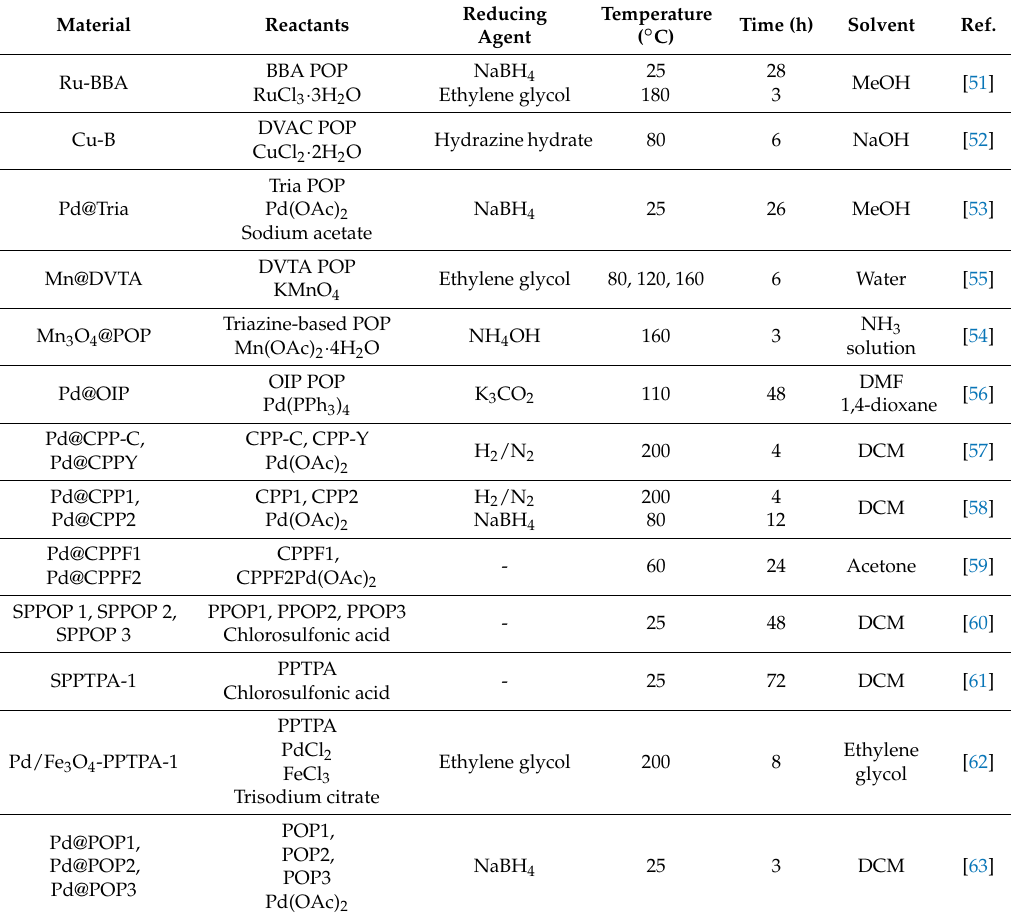
Table 2. Synthesis of functionalized and metal nanoparticles-encapsulated